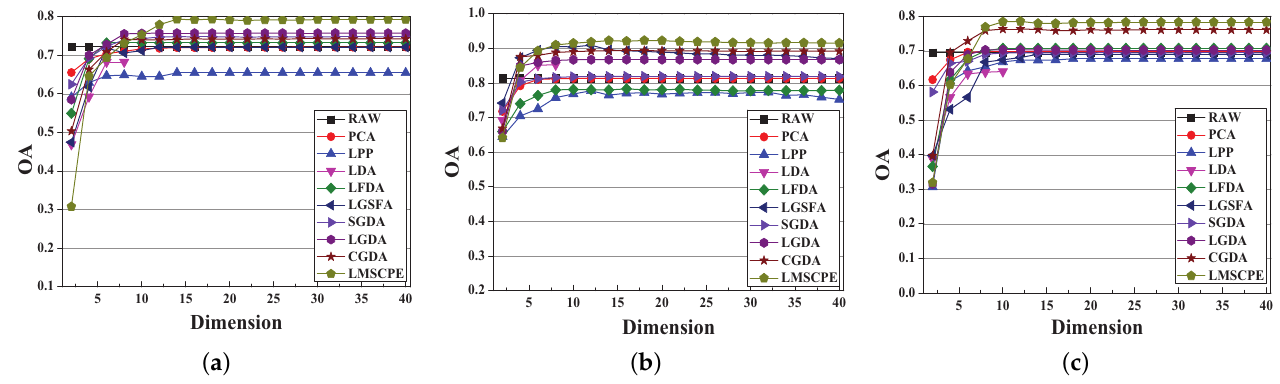
Figure 8. Classification results with different embedding dimensions d . ( a ) PaviaU. ( b ) LongKou. ( c ) MUUFL.